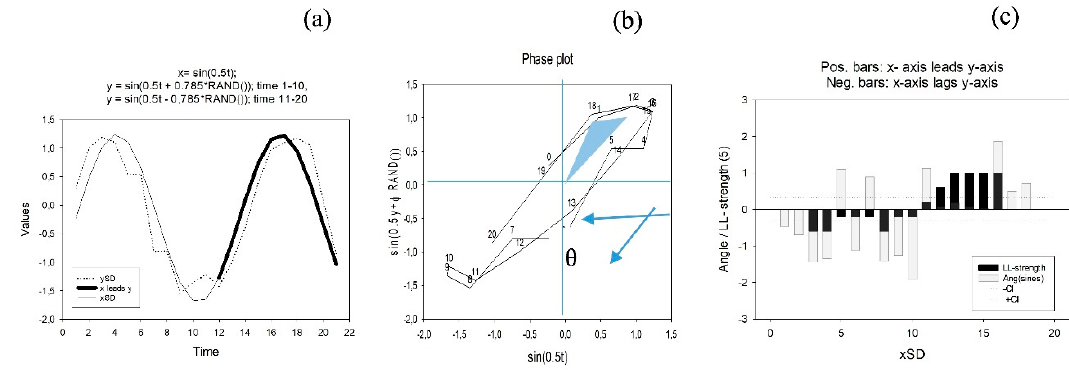
Figure 2. Example: Calculating leading–lagging (LL) relations and LL strength ( a ), two sine functions: The smooth curve is a simple sine function, sin (0.5t), the dashed curve has the form sin (0.5t + φ × RAND()) where φ = + 0.785 for t = 1–10 and φ = − 0.785 for t = 11–20. RAND() is the Excel random generator. The bold part of the simple sine function xSD shows that it leads ySD. ( b ) In a phase plot, with sin (0.5.t) on the x -axis and the sin(0.5t + φ RAND()) on the y -axis, the time series rotates first clock-wise (1 to 10, negative by definition) then counter clock-wise, 11 to 20; θ is the angle between two consecutive trajectories. The wedge suggests the angle between the origin and lines to observations 1 and 2. ( c ) Angles between successive trajectories (gray bars) and LL strength (black bars). LL strength allows some outliers in a pattern that still are characterized as persistent. Dashed lines suggest confidence limits for persistent rotation in the phase plot and persistent leading or lagging relations in the time series plot. Figure redrawn from Seip and Gron [41].